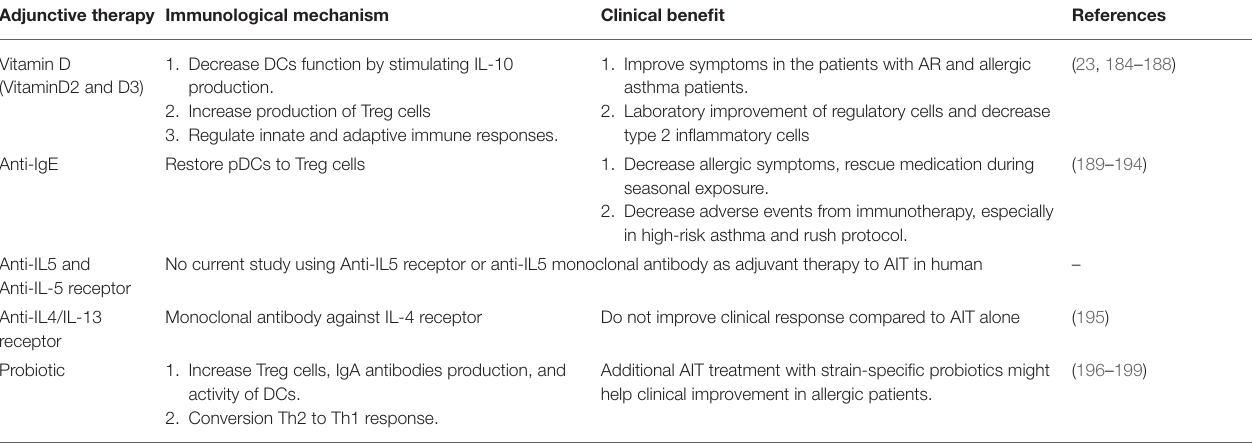
TABLE 2 | AIT and adjunctive